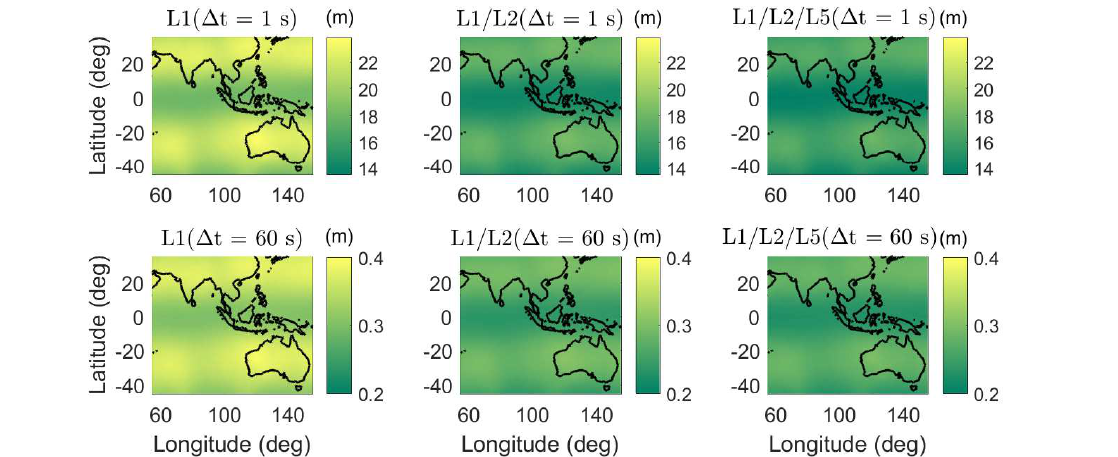
Figure 14. Average formal standard deviations of ambiguity-float heights in the phase-only two-epoch case. The time span between the two epochs are 1 ( top ) and 60 s ( bottom ). Note that the scales of the sub-figures are